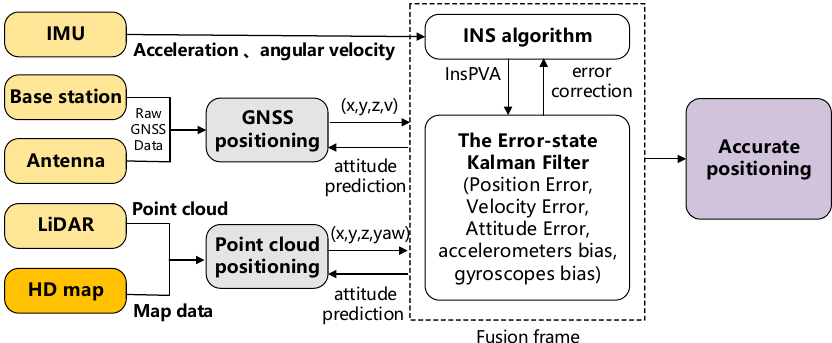
Figure 9. Kalman filter based hybrid data fusion method of positioning.